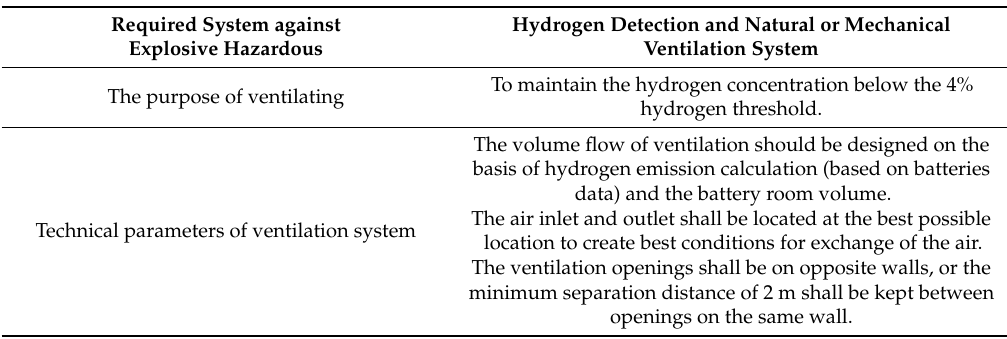
Table 1. Synthesis of the solutions proposed for battery rooms against explosive hazardous in BS EN 62485-2014